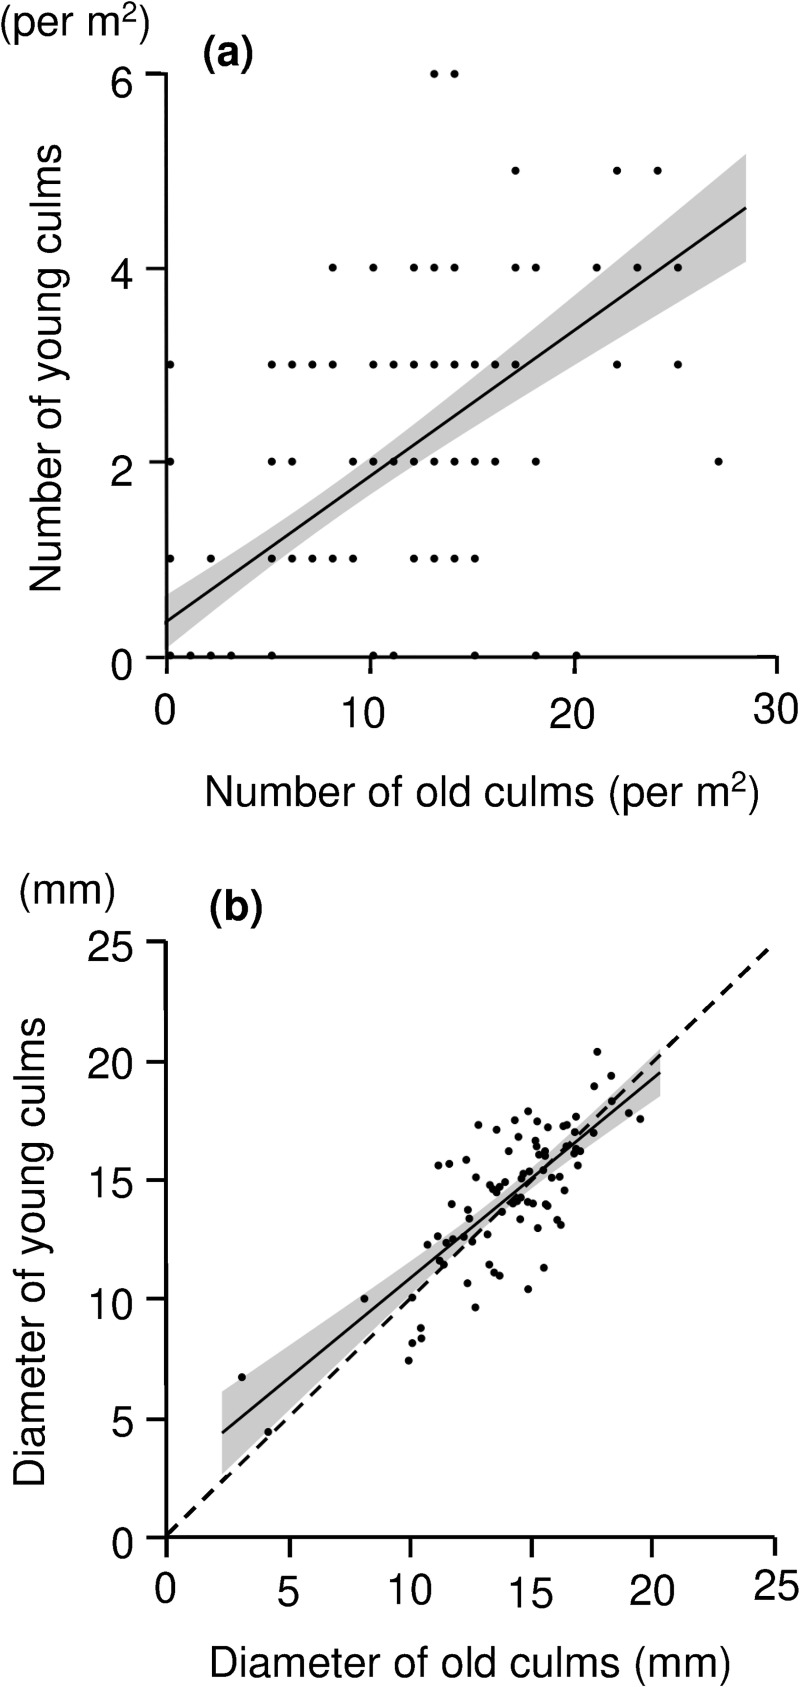
Relationships (a) between numbers of young and old culms and (b) between the diameter of young and old culms. Solid lines and grey zones denote linear regression and 95% CI, respectively. The dotted line on the lower figure has a slope of 1, suggesting no change across years. These figures plot the mean data. Note that several points in the upper figure overlap.